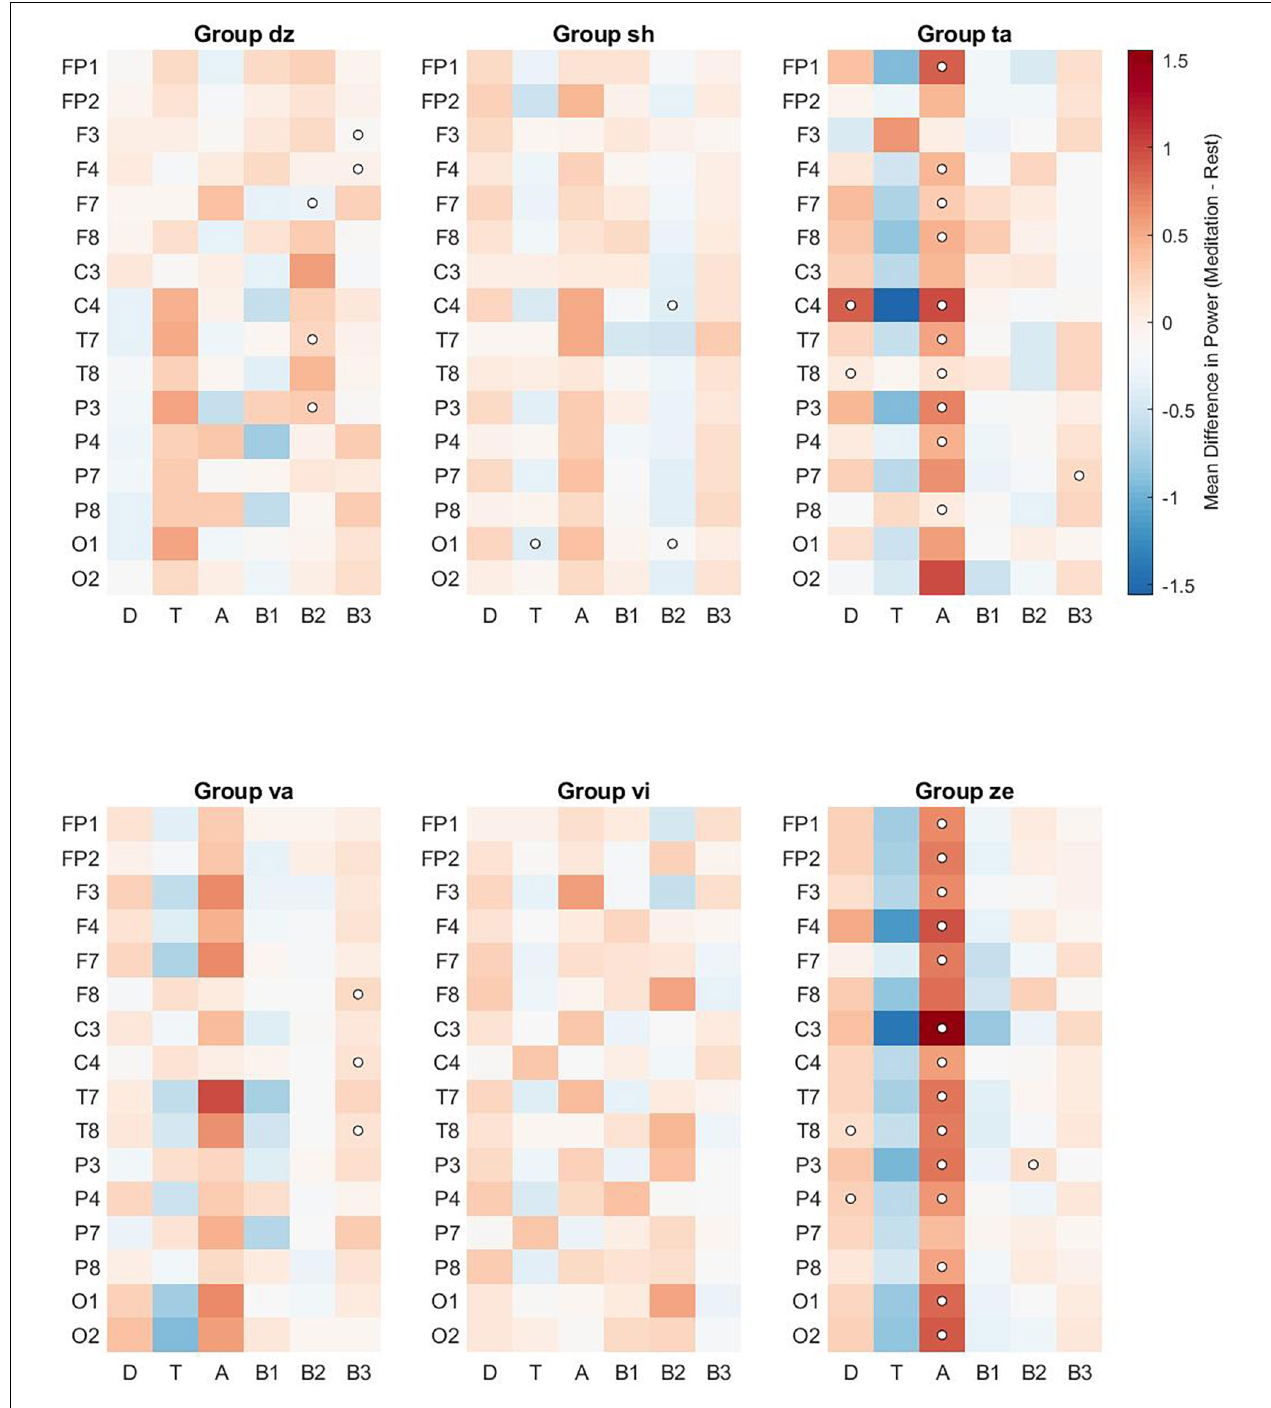
FIGURE 1 | Mean differences in power from meditation and mind-wandering conditions for each of the six meditation groups. Fields with a white circle were significant at the 0.05 level after false discovery rate (FDR) correction for recording sites, frequency bands, and conditions. Sh, shamatha; Va, vipassana; Ze, zazen; Dz, dzogchen; Ta, tonglen; and Vi, visualization.